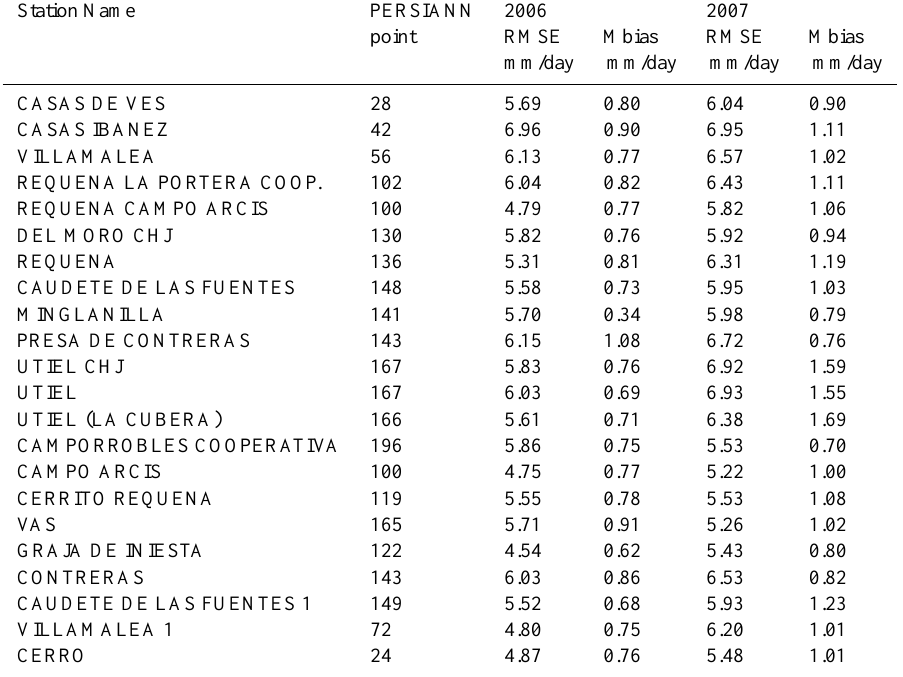
Table 1. List of all the meteorological stations/ rain gauges (1st column) and their nearest PERSIANN points (2nd column) available over the VAS area. The root-mean square error (RMSE) and the mean bias (Mbias) of daily precipitation between each in situ rainfall observation and PERSIANN point are calculated for 2006 and 2007.